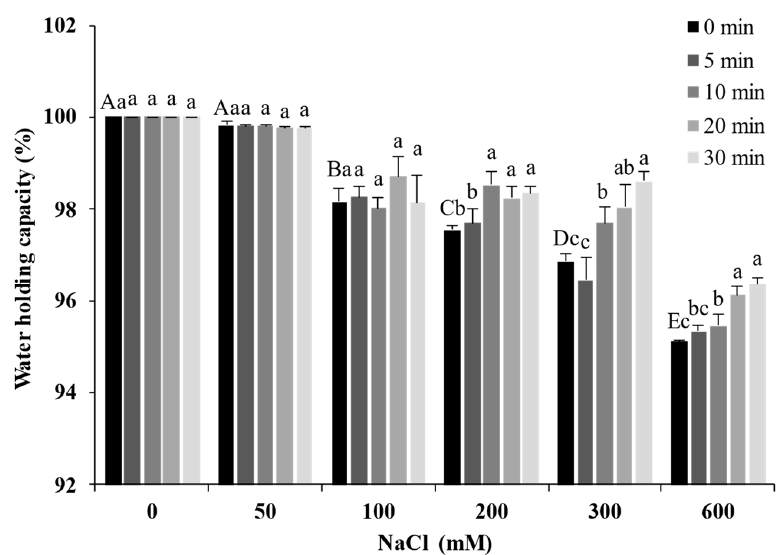
Figure 8. Water-holding capacity of soy protein isolate treated with ultrasound at different NaCl concentrations for different processing times. The upper letters indicate significant differences between the samples without ultrasound treatment in different salt concentrations. The lower letters indicate significant differences between the samples with different ultrasound times in the same salt concentration ( p < 0.05).